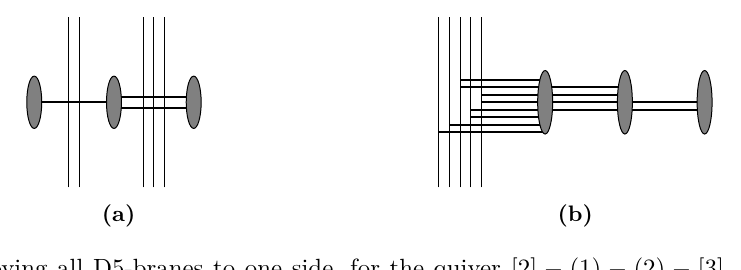
(1) (2) [3] . Each D5-brane − − −